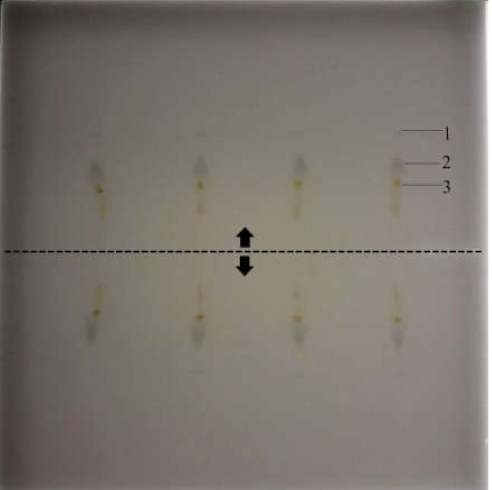
Figure 3. The chromatograms of the samples after the first development. The dashed line marks the path of the pipette delivering the eluent, and the arrows indicate the direction of the eluent migration. ( 1 ) the low retention matrix components, ( 2 ) the zone of the substance of interest (monensin) and the internal standard (nigericin), ( 3 ) matrix components of higher retention than the substances of interest. Mobile phase: 1:1 methanol–toluene ( v / v ). Stationary phase: HPTLC Silica gel. Plates’ images were captured under white light illumination. Samples: extract from premixture with